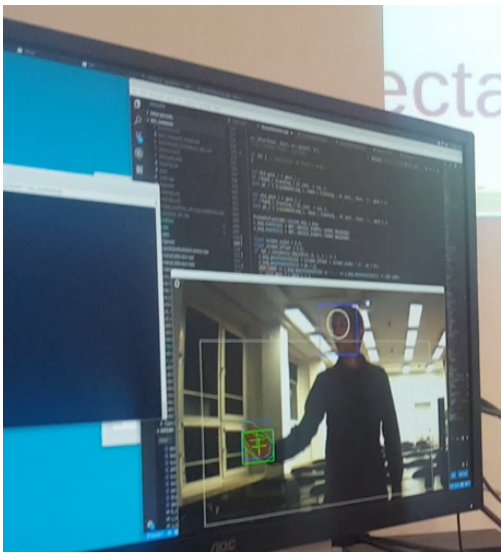
Figure 36. A visual feedback window for the HCI